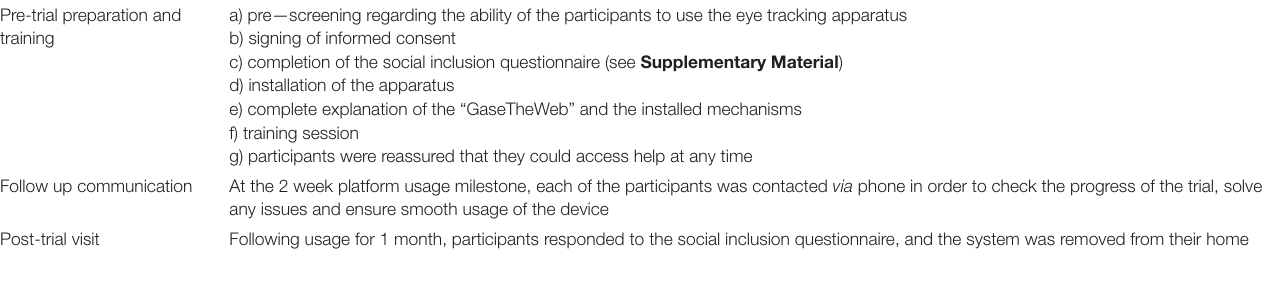
TABLE 2 | Procedure of the 1-month study. Pre-trial preparation and